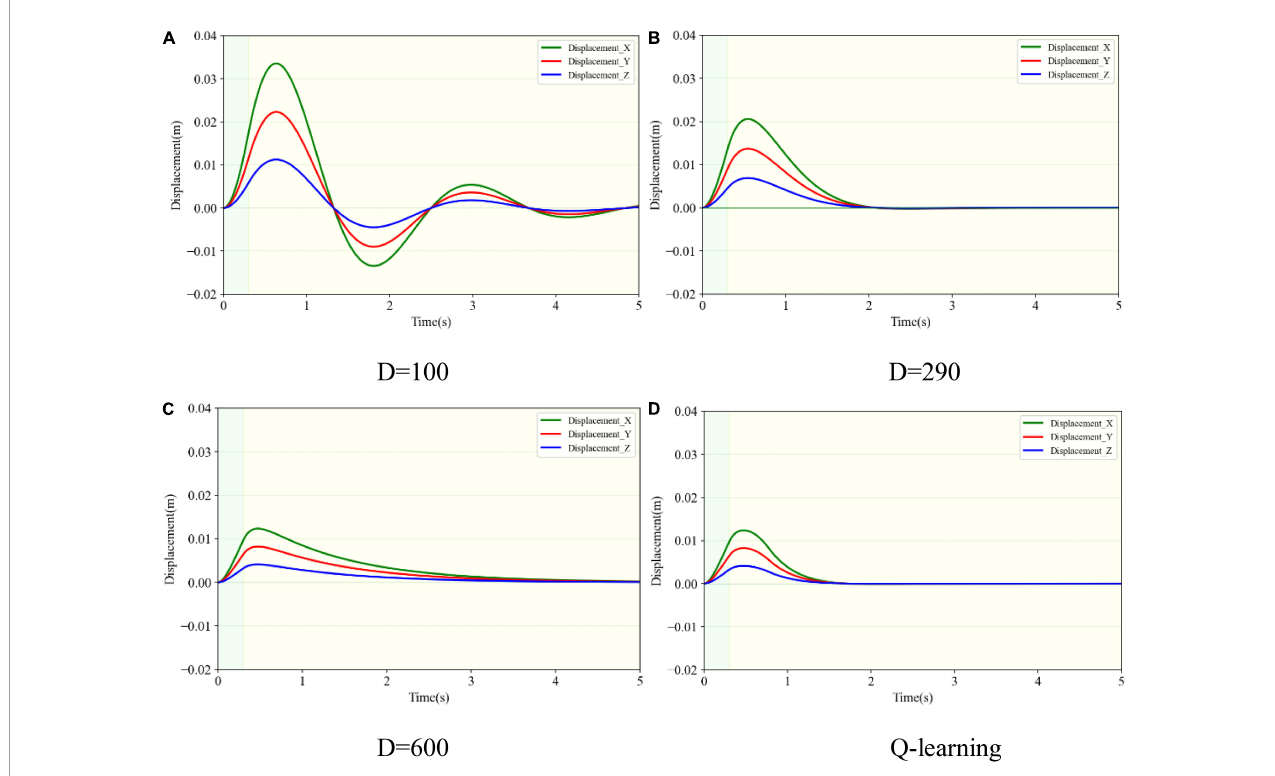
FIGURE11 Three-dimensional displacement changes of the robotic end subjected to three-dimensional impact. (A) Under damping case. (B) Critical damping case. (C) Over damping case. (D) Variable damping case based on Q-learning